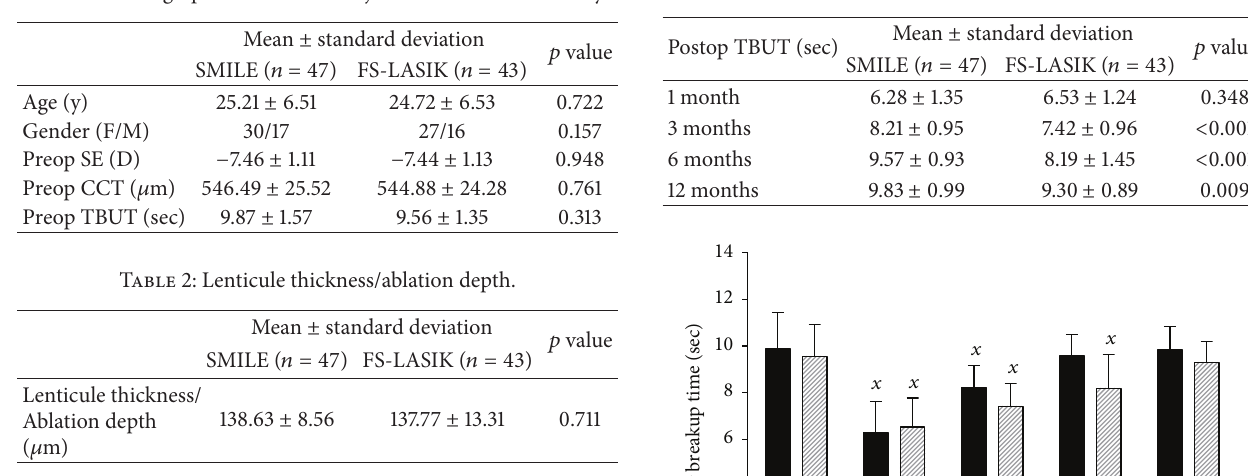
Table 1: Demographic data of the subjects included in this study.